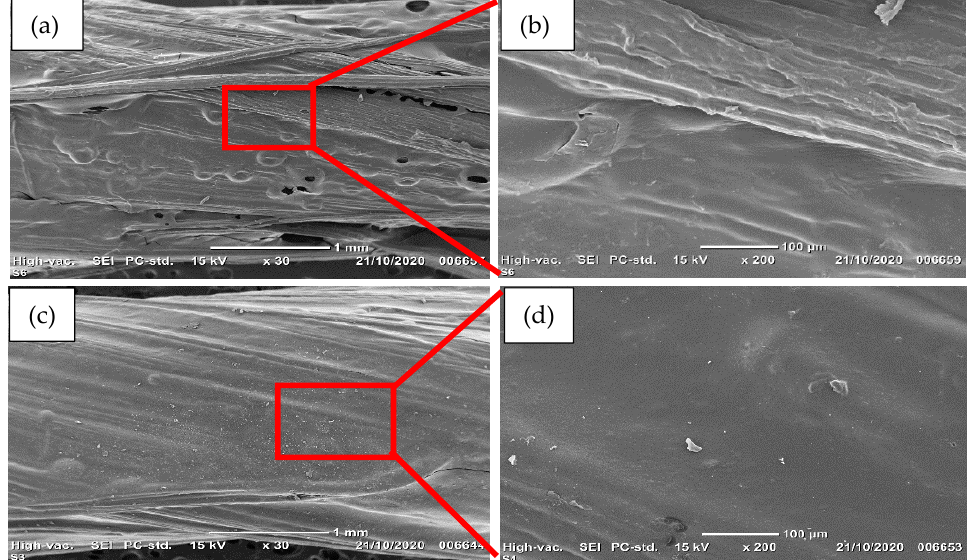
Figure 3. SEM images: ( a ) sensor yarn for two coated layers of PEDOT:PSS and ( b ) selected red line area. ( c ) Sensor yarn for four coated layers of PEDOT:PSS and ( d ) selected red line area.